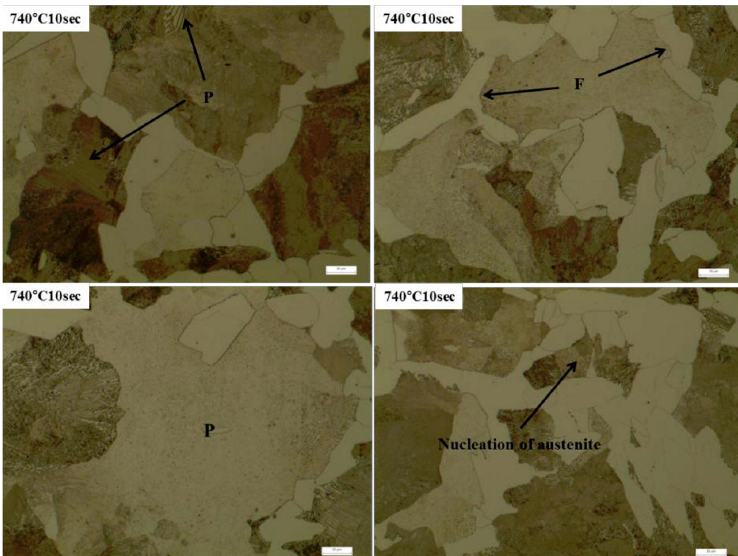
FIG. 2. OPTICAL MICROGRAPHS FROM LEAD BATH FURNACE AT 740°C FOR 10 SECOND HOLDING TIME